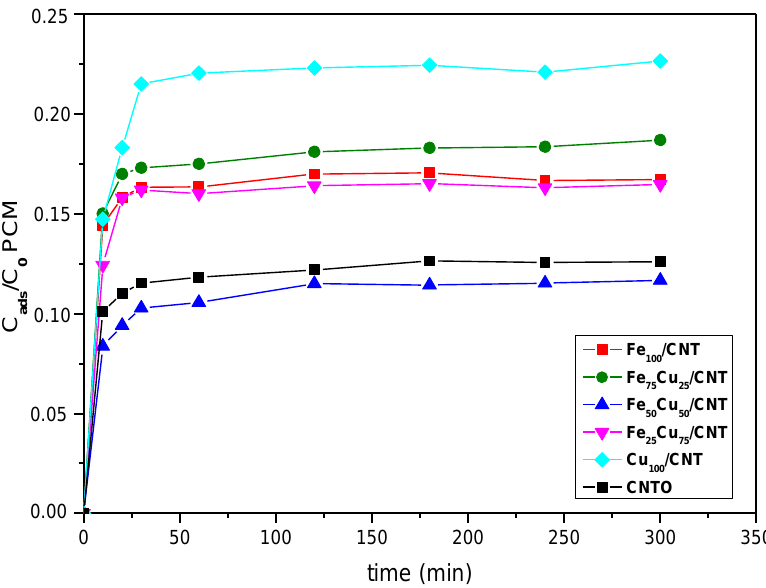
Figure 3. Adsorption kinetics of paracetamol (PCM; C 0 = 50 mg/L) at 25 °C on CNTO and Fe 100− Cu x /CNT samples.